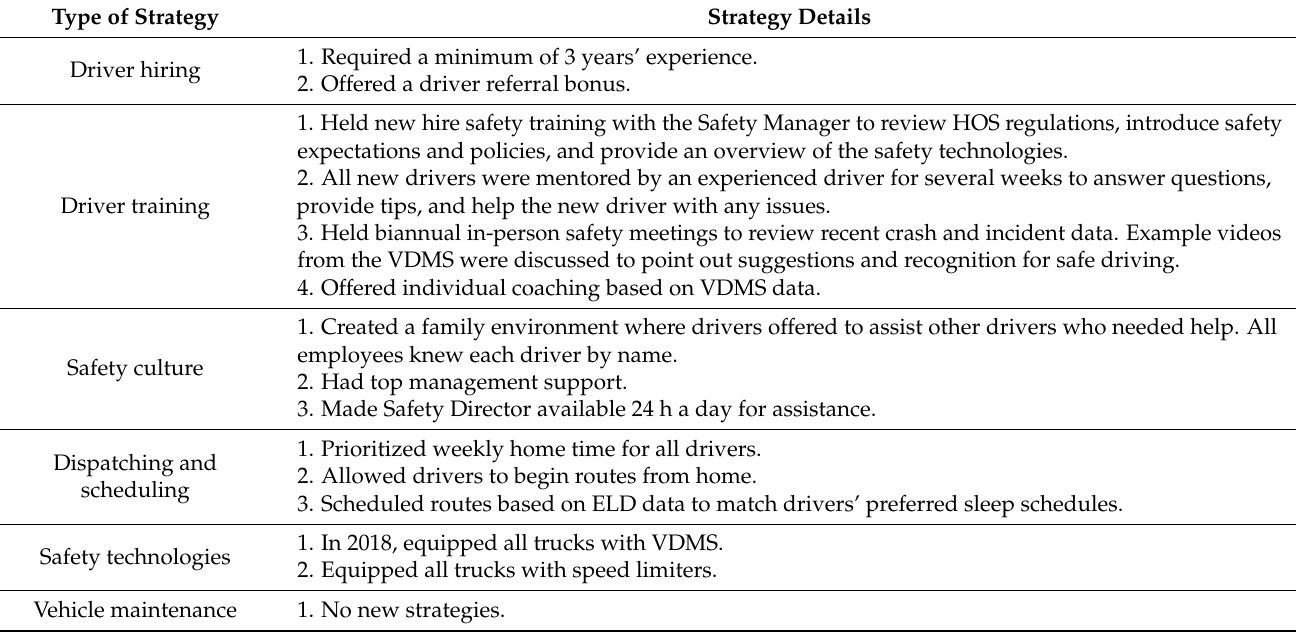
Table 11. Fleet I’s safety improvement